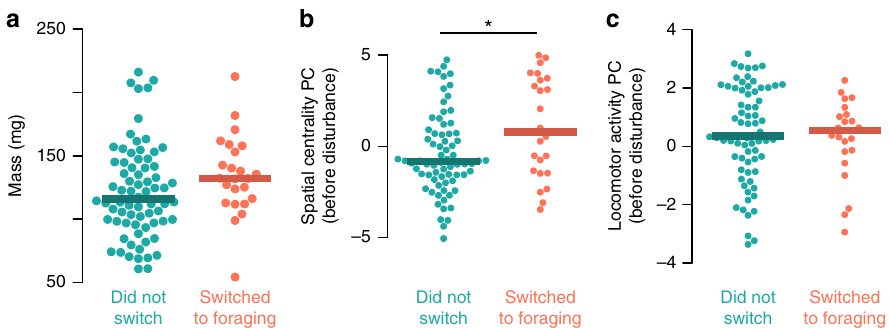
Fig. 6 Spatial centrality before disturbance predicts foraging initiation after disturbance. Beeswarm plots of body mass (mg, a ), spatial centrality score ( b , PC1), and locomotor activity score ( c , PC2) by whether workers initiated foraging after disturbance, among workers that performed no foraging before disturbance. Filled points show mean values for individual workers in the three days before disturbance, and thick lines indicate median values. * p < 0.05 in